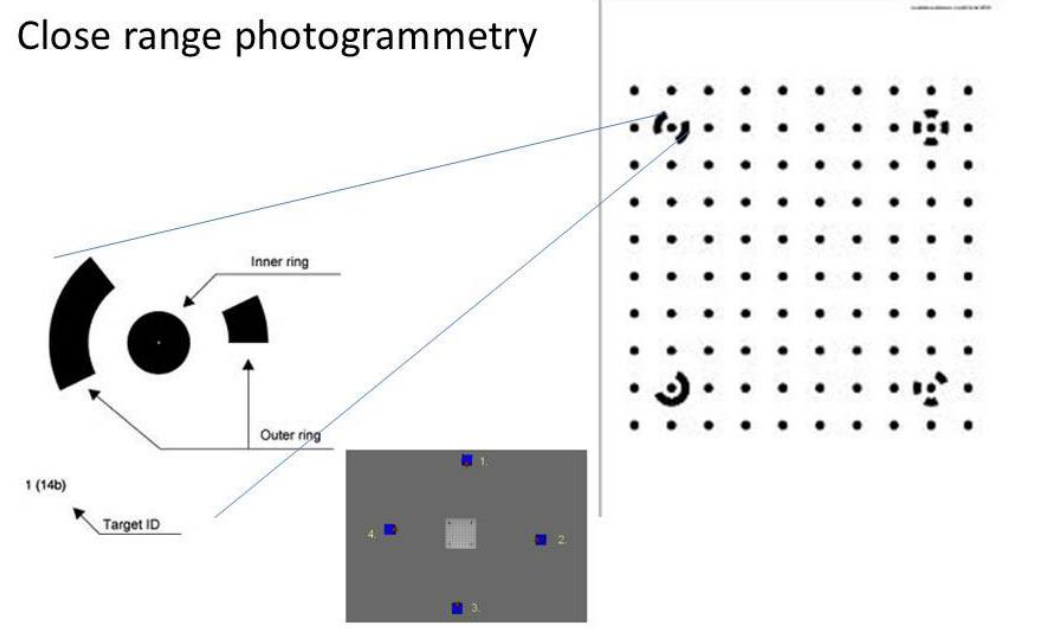
Figure 1. Calibration sheet, used to calibrate the cameras used in the study (see more details in the Photomodeler® help